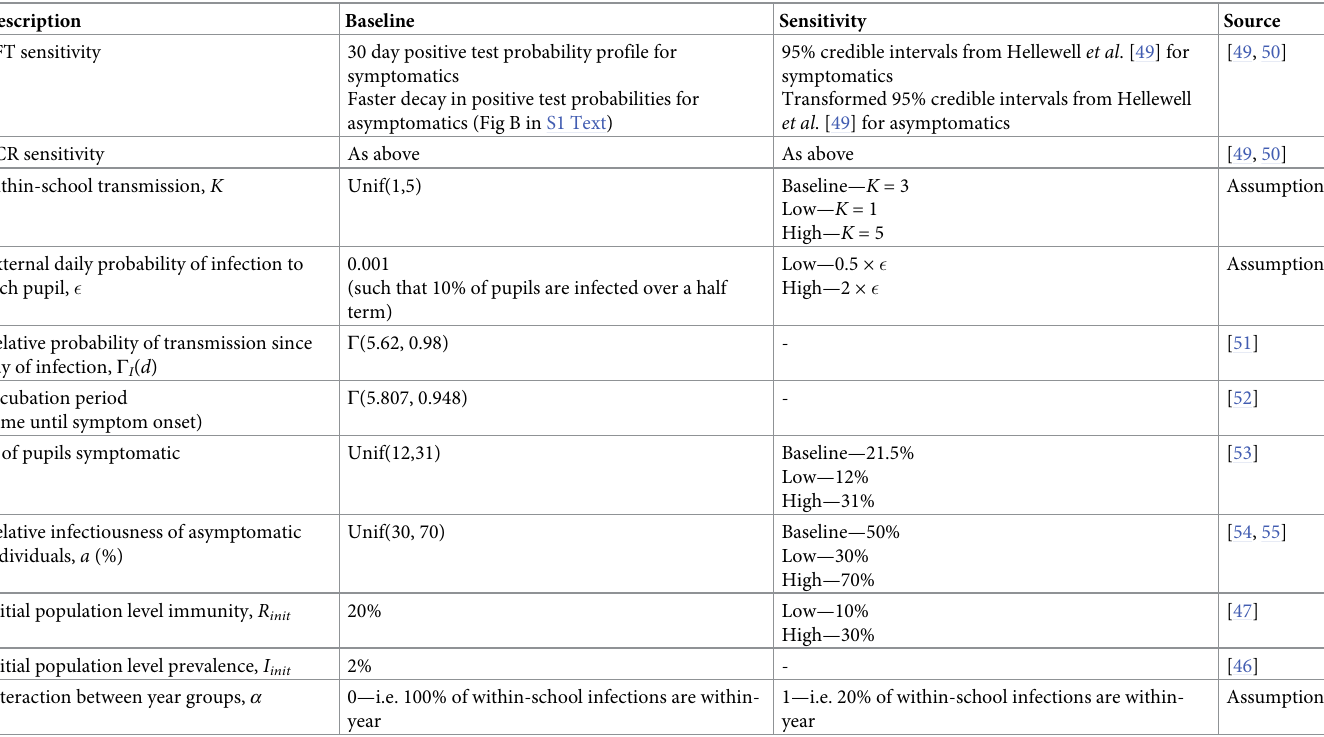
Table 1. Description of model parameters, our baseline parameterisation and the alternative values considered in the univariate sensitivity